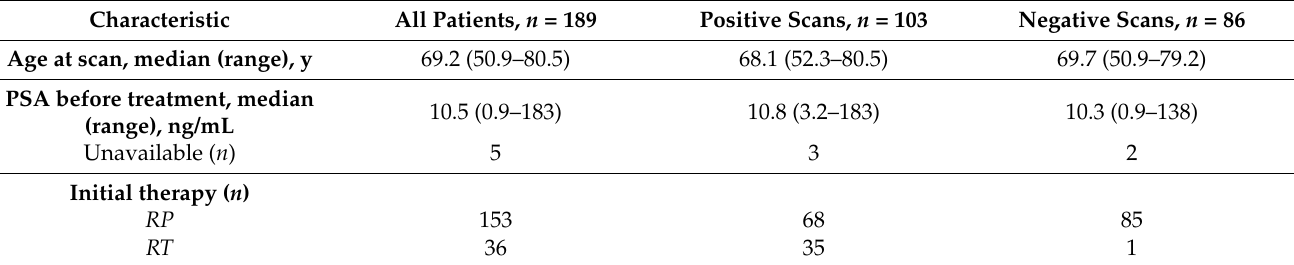
Table 1. Patient summary (All patients).